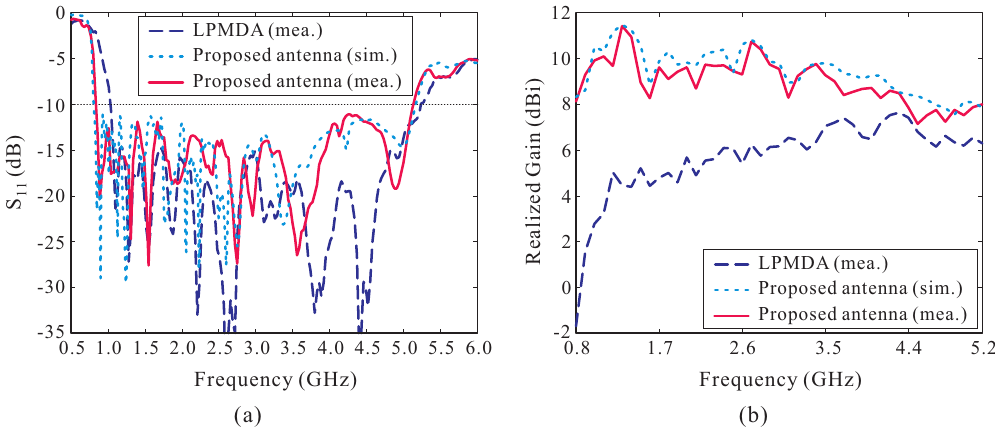
(mea.)Proposed antenna (sim.) Proposed antenna